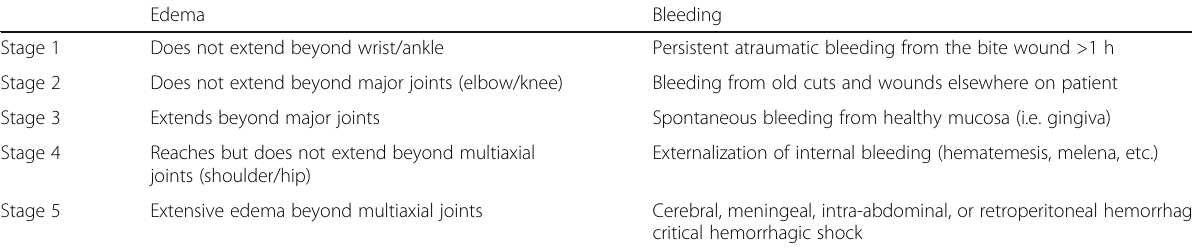
Table 2 Clinical progression of edema and bleeding for viper envenomations in Benin Edema